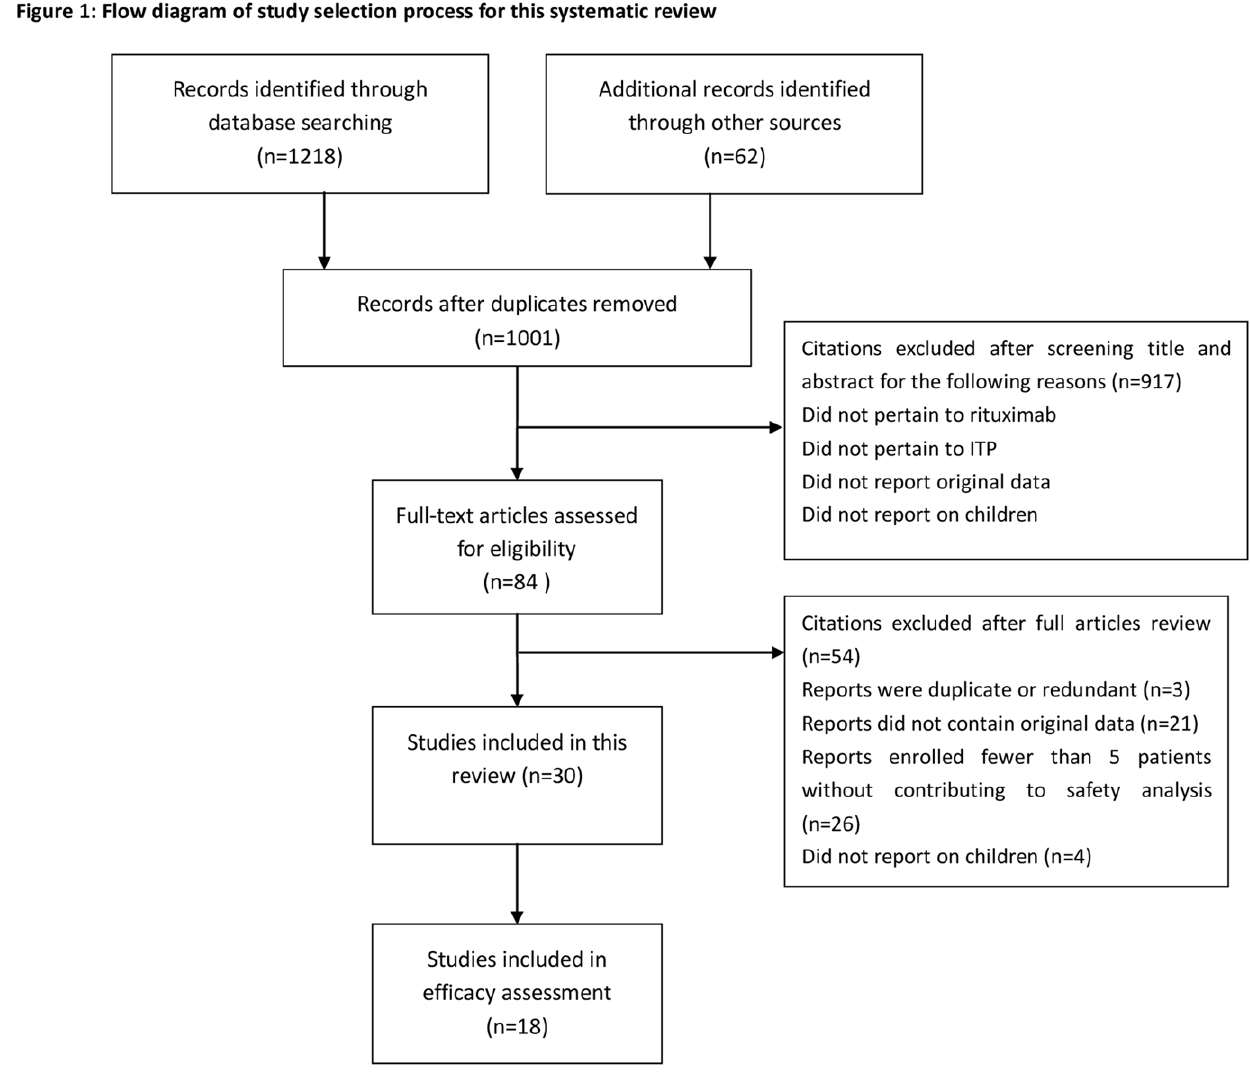
Figure 1. Flow diagram of study selection process for this systematic review. This is a modified four-phase PRISMA 2009 flow diagram that maps out the number of records identified, included and excluded, and the reasons for exclusions.